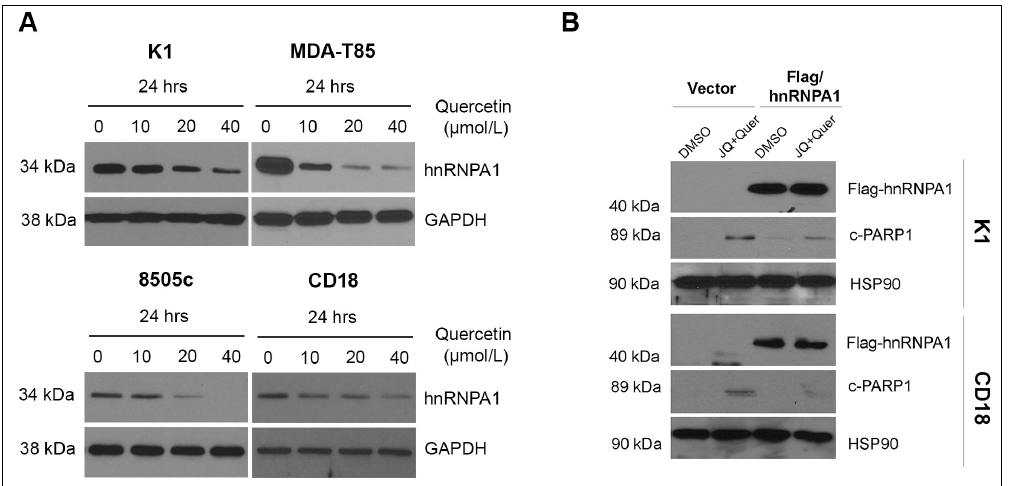
Figure 3. hnRNPA1 mediates the anti-tumor effects of Quercetin. ( A ) Thyroid and pancreatic